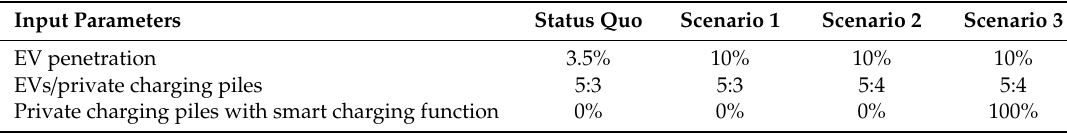
Table 1. Parameters of di ff erent scenarios.